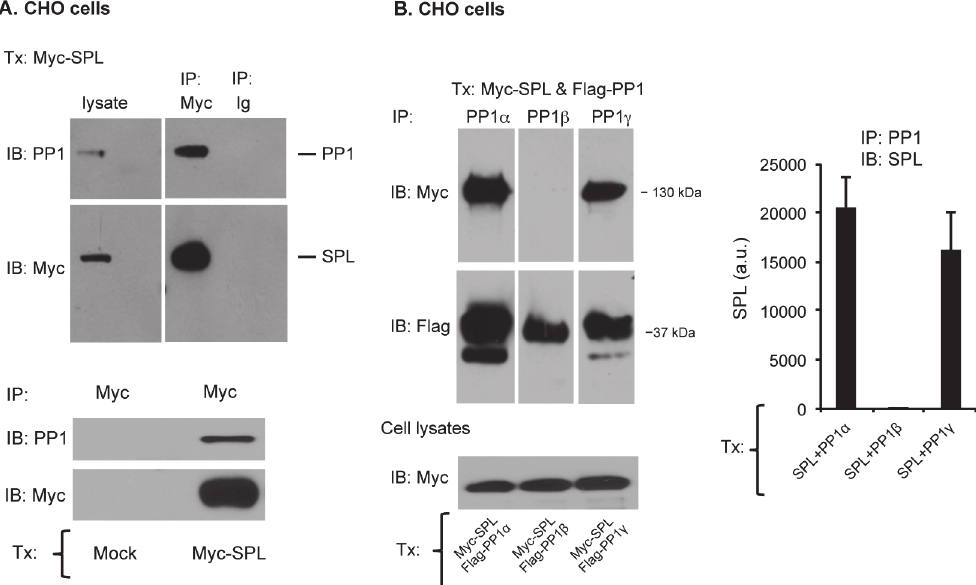
Fig 2. Formation of the SPL/PP1 complex in CHO cells. (A) Top : Lysates were prepared from CHO cells transfected with a full length, Myc-tagged spinophilin (Myc-SPL). Proteins were precipitated with an anti-Myc antibody or nonimmune immunoglobulin (Ig) and then probed for PP1 and Myc-SPL. Bottom : Lysates were prepared from mock-transfected control CHO cells or cells transfected with a full length, Myc-tagged spinophilin (Myc-SPL). Proteins were precipitated with anti-Myc and then probed for PP1 and Myc-SPL. (B) Lysates were prepared from CHO cells transfected with full length Myc-SPL and either PP1 α , β or γ . Proteins were precipitated with PP1 isoform-specific antibodies and then probed for Myc-SPL or Flag-PP1 (mean ± SEM, N = 3). Note that all the samples were run on the same gel and, as indicated by the vertical gaps, two marker lanes were